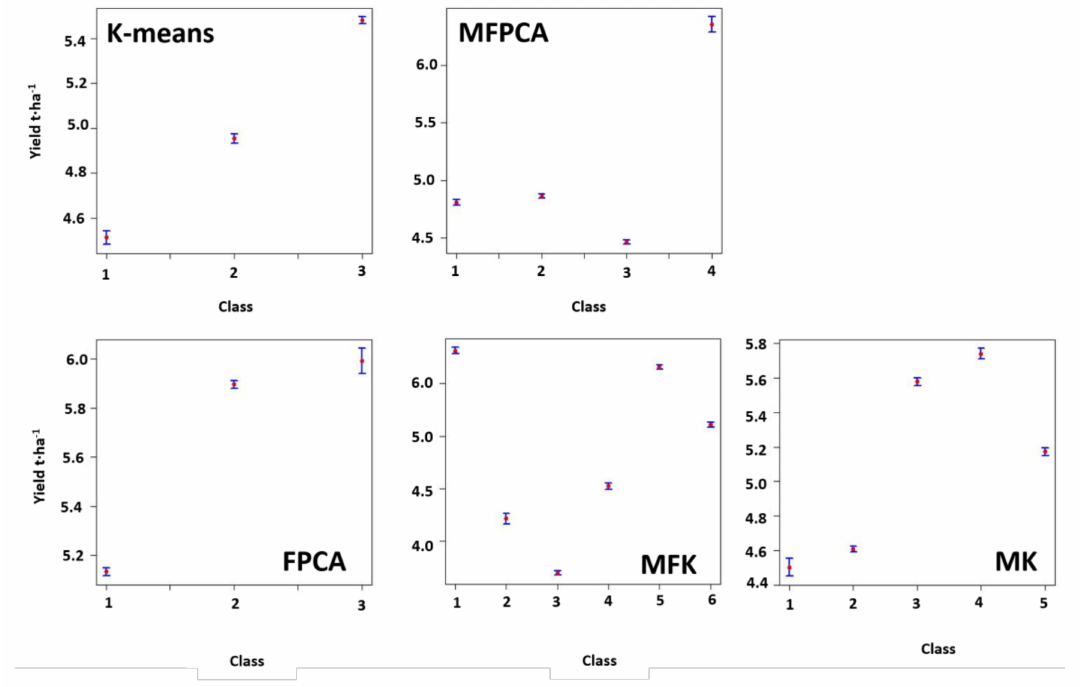
Figure 6. Example of the expected values (red point) and the relative 99% confidence intervals (blue dashed line) of the yield in the polygons obtained by all the clustering methods for FOI